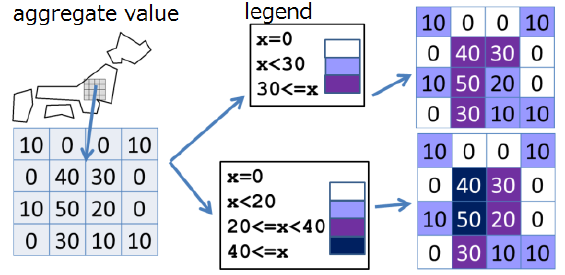
Fig. 6. Examples of legend